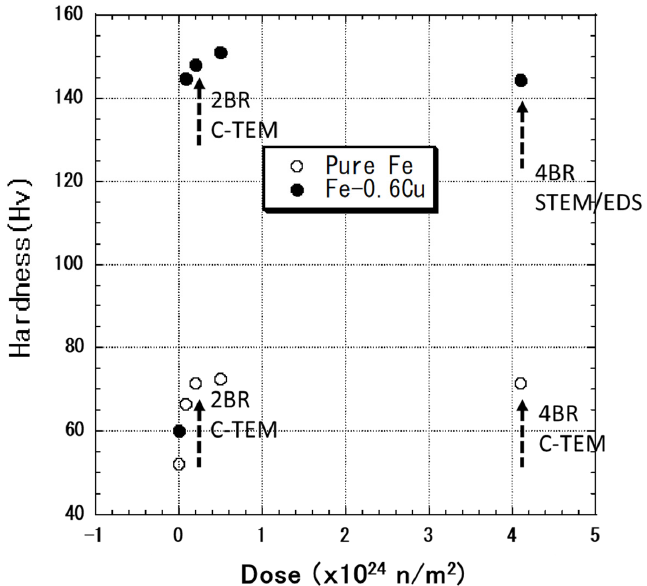
Figure 1. Dose dependence of radiation-induced hardening of pure Fe and Fe-0.6wt%Cu alloy.